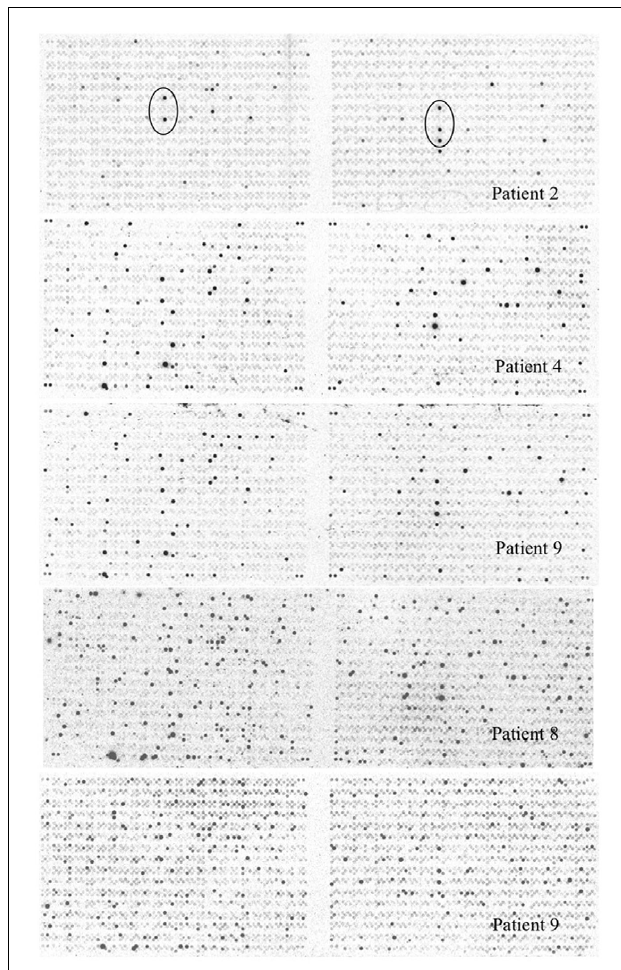
FIGURE 1 | M ycobacterium tuberculosis genomic array hybridized with radiolabeled cDNAs obtained by SCOTS from sputum bacteria. Array patterns obtained by hybridizing cDNAs obtained by three rounds of SCOTS from bacteria in five un-induced sputum specimens as described in Section “Materials and Methods” are shown. Array features showing the highest levels of hybridization for patient 2 (circled) were readily detected for all specimens, and correspond to ORFs Rv1197 ( esxK ) and Rv1198 ( esxL ) on the left, and Rv2346c ( esxP ), Rv2347c ( esxO ), and Rv1047 on the